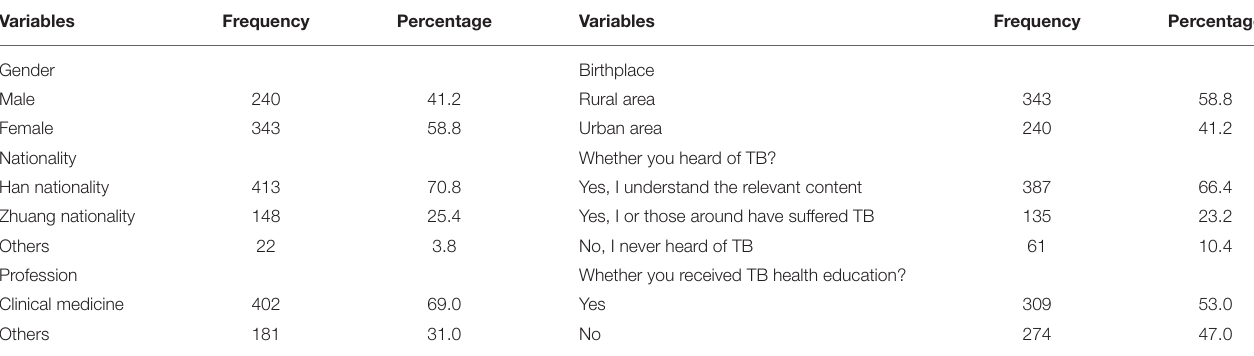
TABLE 1 | Socio-demographic characteristics of study freshmen ( n =